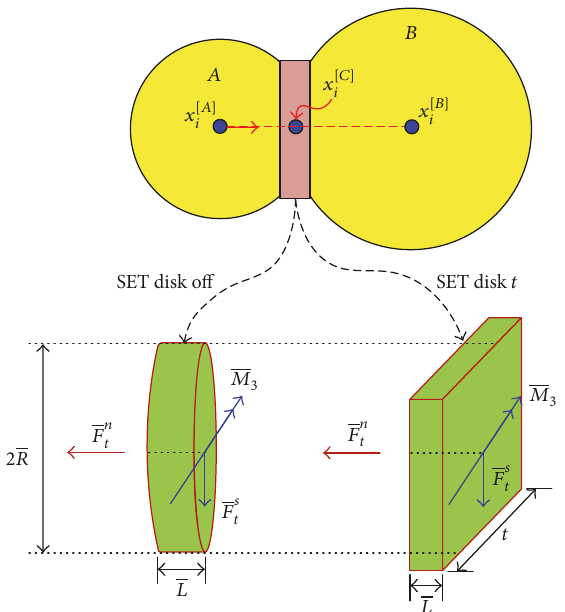
Figure 4: Illustration of the parallel bond model in PFC [42].